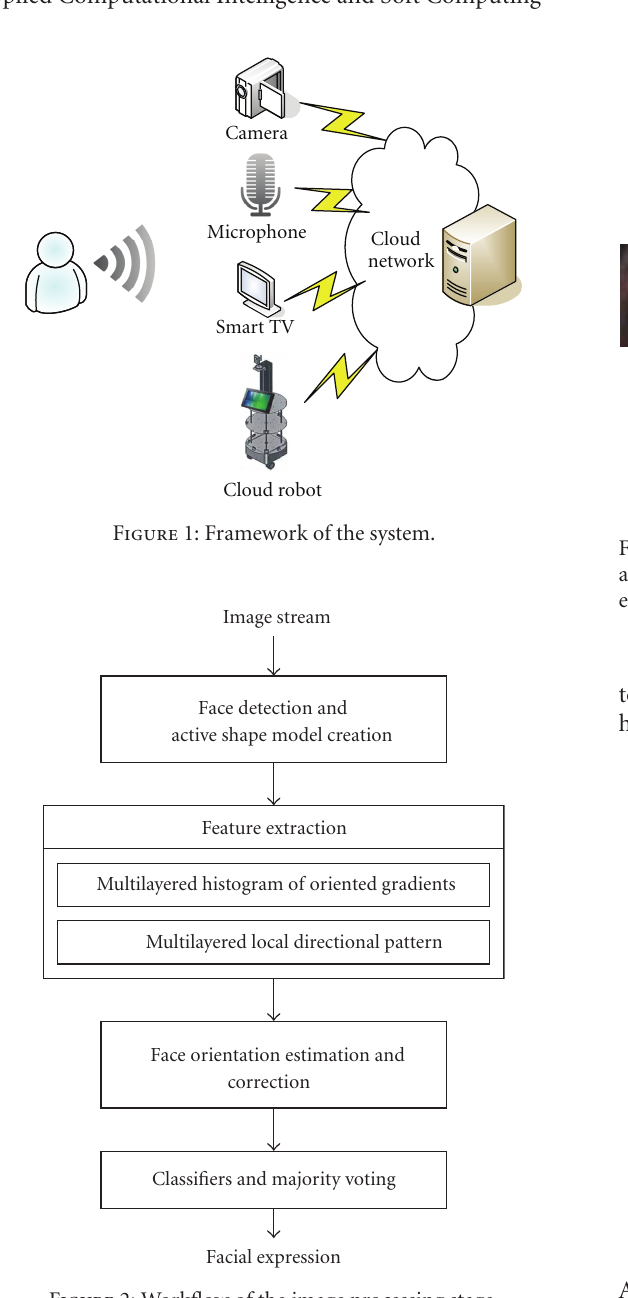
Figure 2: Workflow of the image processing stage.